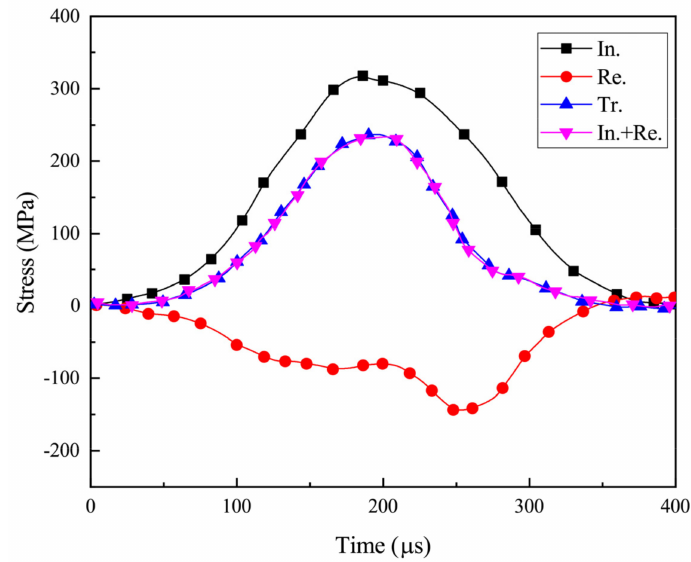
Figure 5. Stress balance verification.